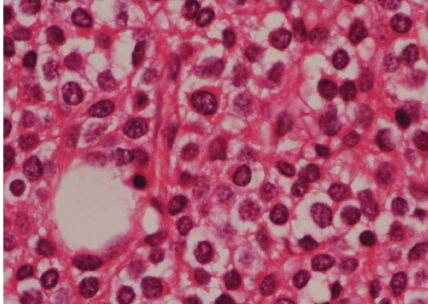
Figure 4: The biopsy specimen of the right femoral lesion showed diffuse neoplastic infiltration consisting of cells with round, oval, regular nuclei, and medium-sized, clear cytoplasm (H&E, ×